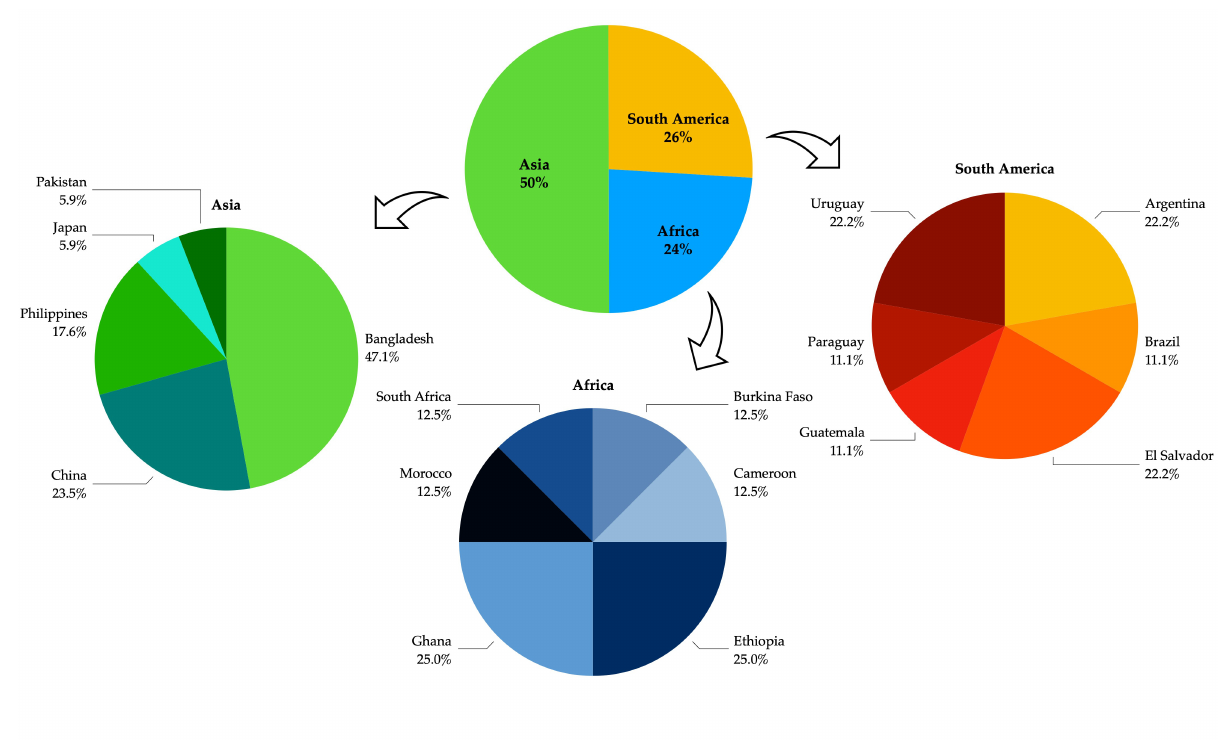
Figure 4. Percentage of infested plant material seized at BIPs based on country of origin.